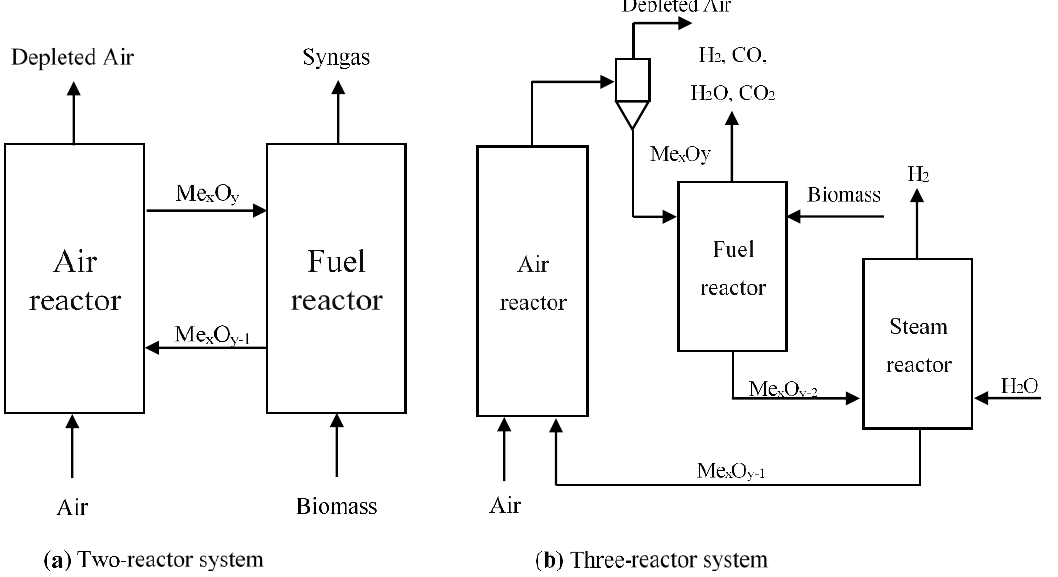
Figure 4. BCLG configurations for hydrogen enrich gas production: ( a ) Two-reactor system and ( b ) Three-reactor system.